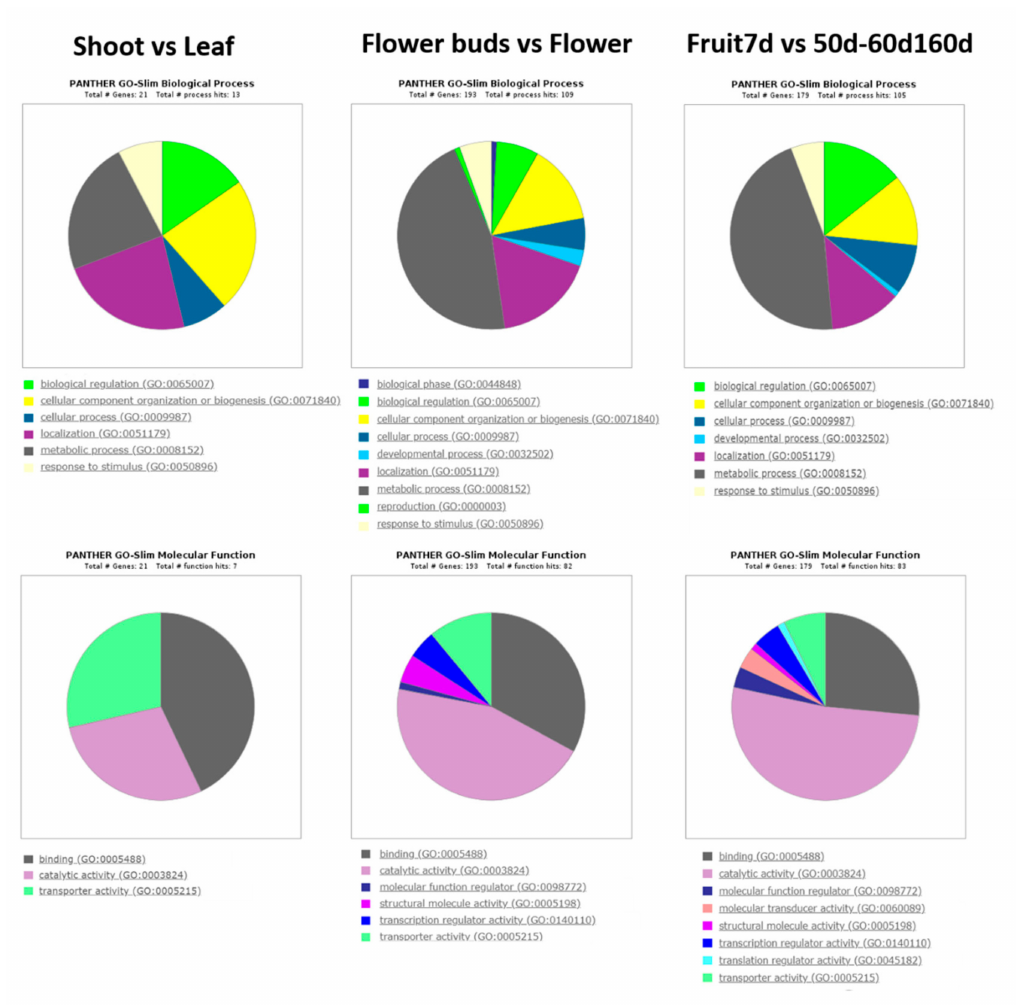
Figure 3. Panther GO annotations for each comparative plant tissues shoot vs. leaf, flower bud vs. flower and fruit7 d vs. 50 d–120 d–160 d (including all fruit tissues